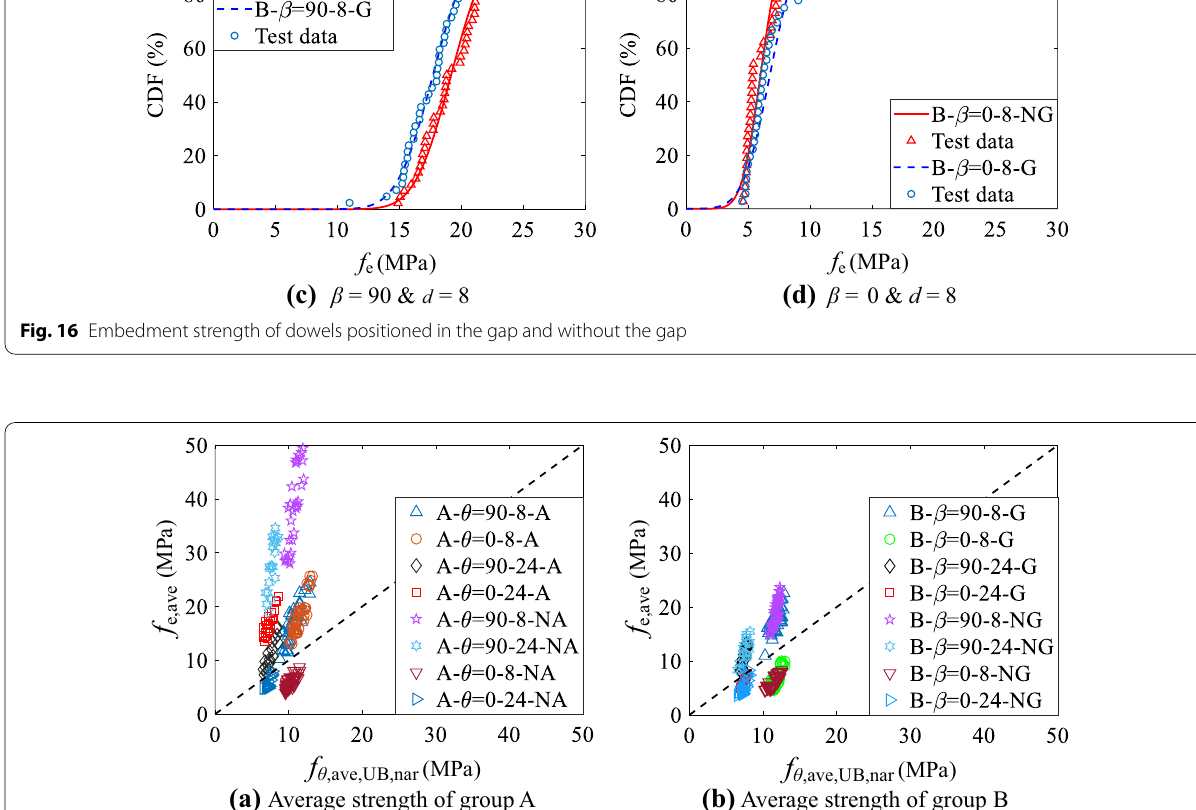
Fig. 17 Verification of the empirical Eq.